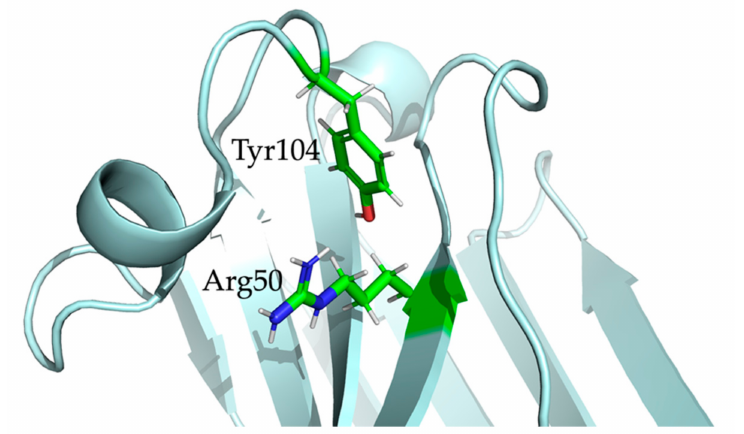
Figure 7. The Tyr104 phenolic ring in the CDR3 and the Arg50 β CH2 in β − strand C” of Nb23 show proximity as per the assigned NOE constraints. This indicates the possible presence of a guanidinium − π interaction, partially keeping the CDR3 in a defined orientation. The cartoon shows one of the arrangements of the residues in the NOE − restrained best cluster.